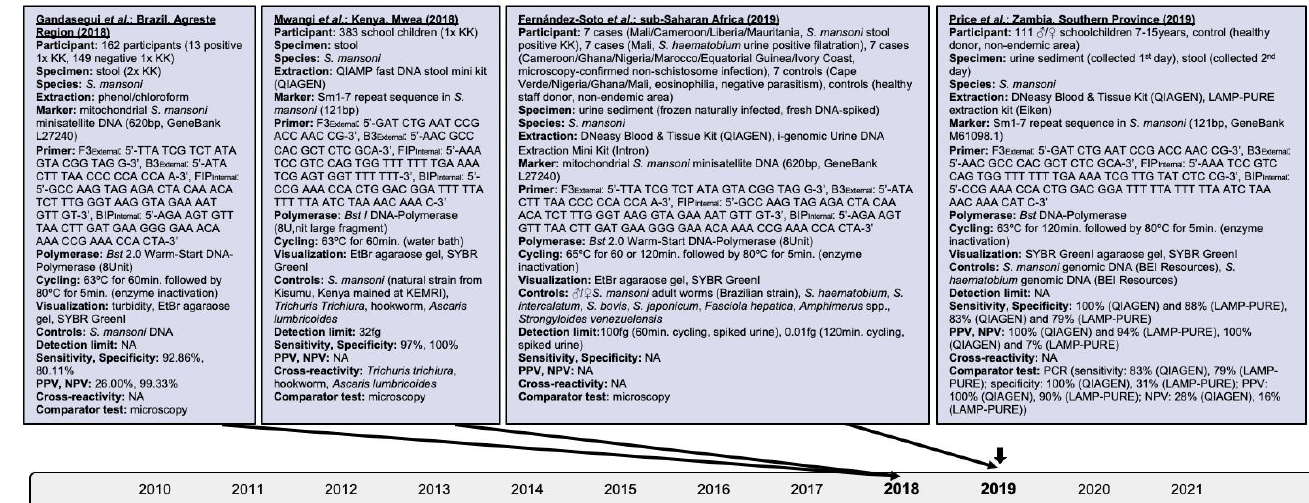
Figure 4. Articles identified on the isothermal diagnosis of Schistosoma mansoni with details on participants, specimens, assay features, and test evaluation in terms of detection limits, sensitivity, specificity, PPV and NPV versus a comparator test by chronological order of publication date. Arti- cles highlighted in light blue delineate schistosomal diagnosis based on loop-mediated isothermal amplification (LAMP). We searched databases of PubMed, Embase and Web of Science for suitable publications on the isothermal diagnosis of schistosomiasis among clinical specimens collected from human subjects by applying the following terms: “schistosomiasis”, “Schistosoma”, “snail fever”, “schistosomiasis MeSH Terms”, ”isothermal”, “diagnosis/diagnostic”, “detection”, and “assay”. The last searches were performed on 31 December 2021. Publications included after removing duplicates, screening titles and abstracts, reading full-texts, and complementing through reference searches were not restricted by time period, but by the availability of full-texts available in English. Experimental animal studies, investigations on intermediate mollusk hosts, reviews and mathematical models were excluded unless considered highly relevant. Abbreviations: S. = Schistosoma , KK = Kato-Katz, bp = basepair, min. = minutes, EtBr = ethidium bromide, ♂︎ = male, ♀︎ = female, PCR = polymerase chain reaction, PPV = positive predictive value, NPV = negative predicitive value, fg = femtogram, Bst = Bacillus stearothermophilus , NA = not available.